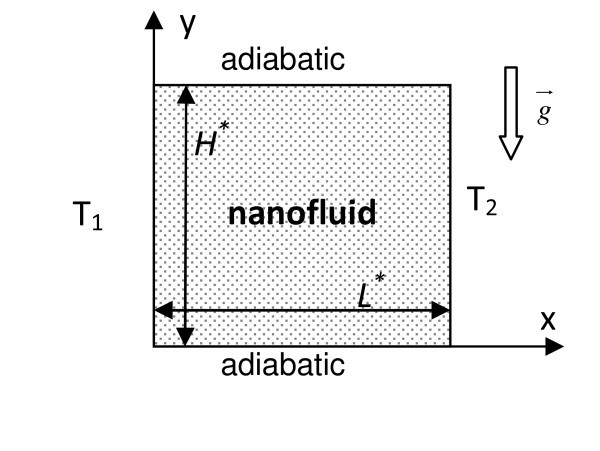
Physical model and coordinate system.